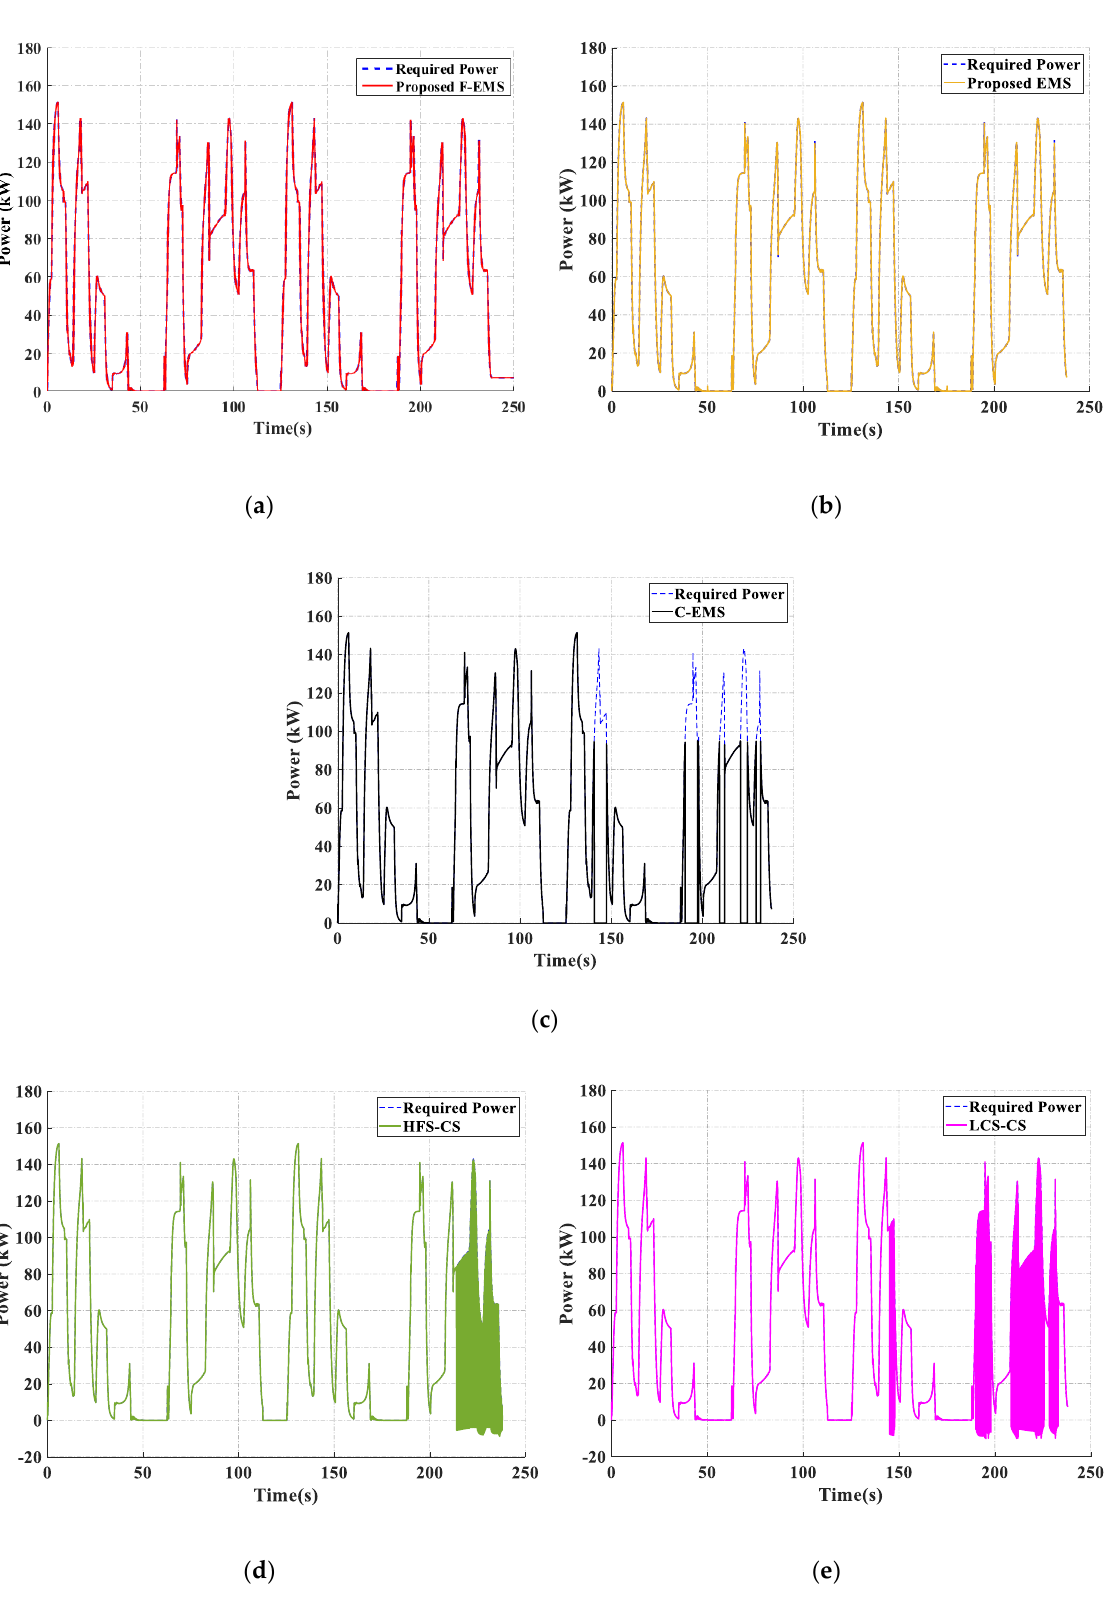
Figure 11. Power released from the HPS for the five strategies: ( a ) proposed F–EMS, ( b ) proposed EMS, ( c ) conventional EMS (C–EMS), ( d ) HFS–CS, and ( e ) LCS–CS.